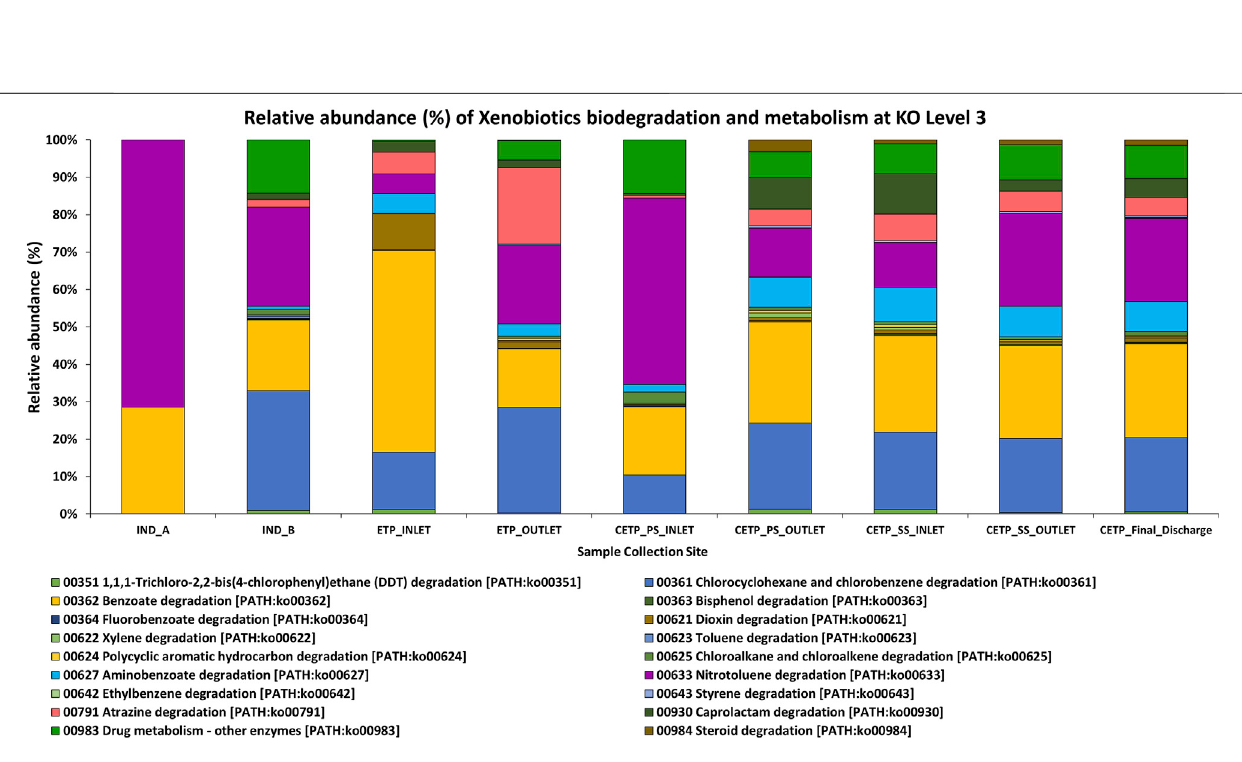
Frontiers in Environmental Science |